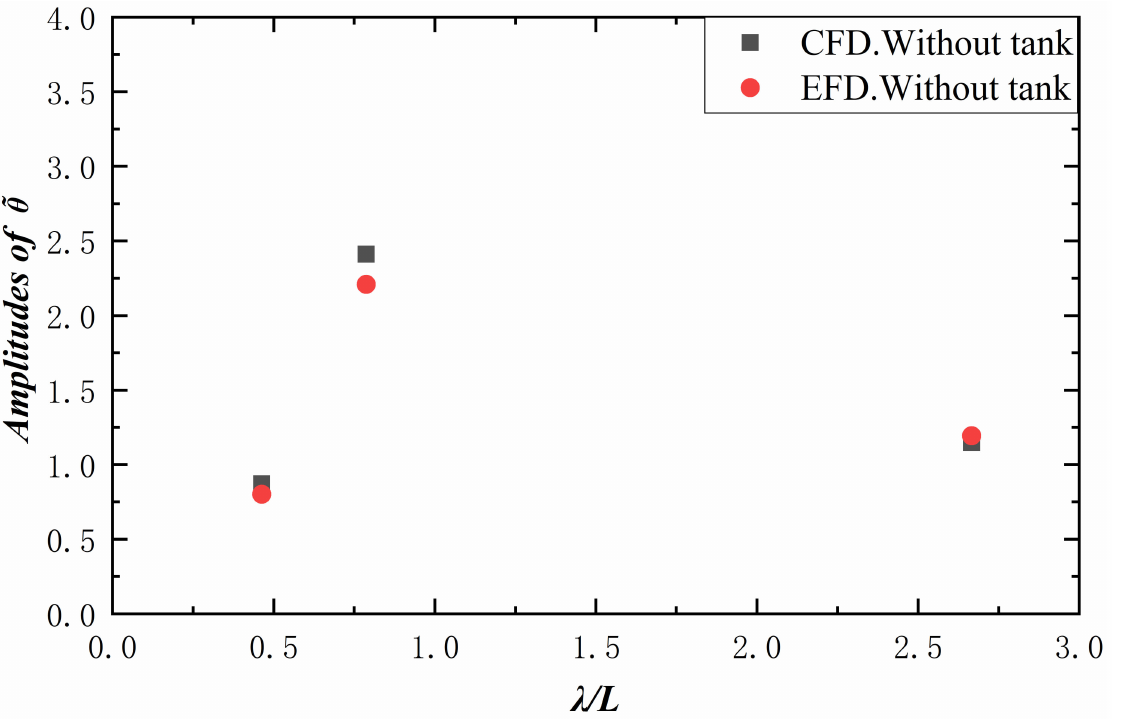
Figure 12. For the ship in beam waves, comparative roll amplitudes by CFD and EFD without accounting for sloshing in